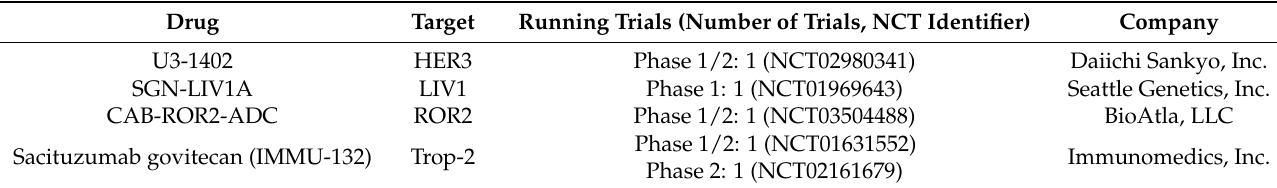
Table 2. Investigated ADCs in breast cancer targeting receptors other than